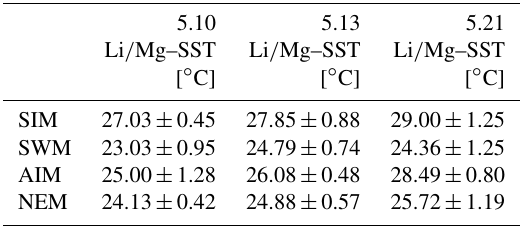
Table 1. Mean seasonal SSTs ( ± 1 σ ) inferred from multi-year monthly mean Li / Mg ratios of individual corals from Masirah Is- land. Uncertainty (1 σ ) represents variability between equal seasons of consecutive years. Seasonal abbreviations: NEM (northeast mon- soon), SIM (spring intermonsoon), SWM (southwest monsoon), AIM (autumn